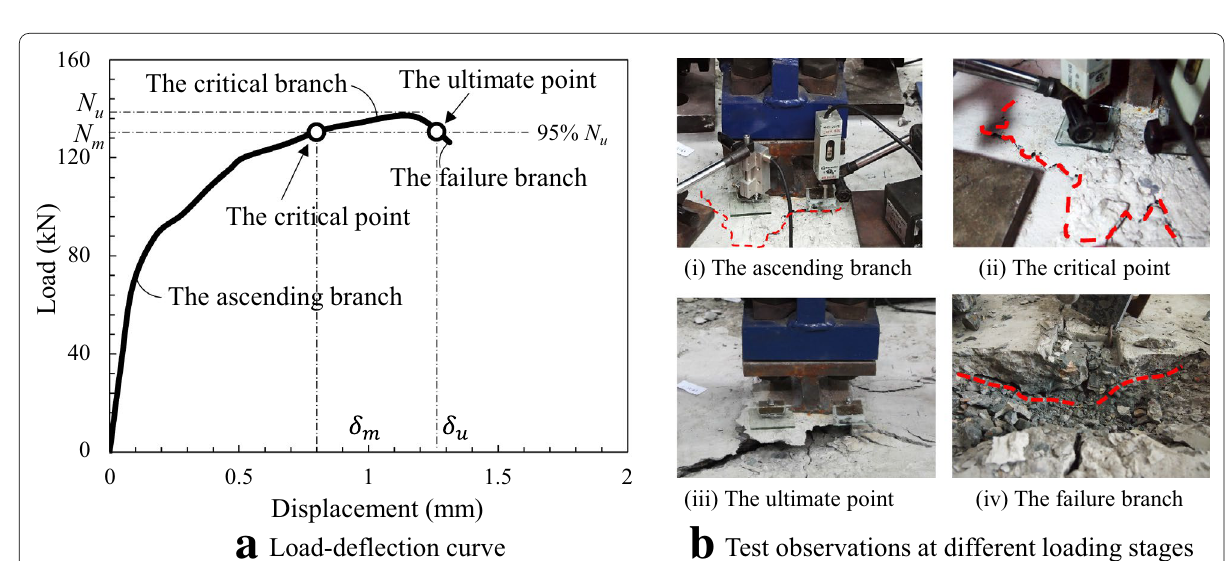
Fig. 8 Load–deformation behavior of the anchorage concrete (Specimen